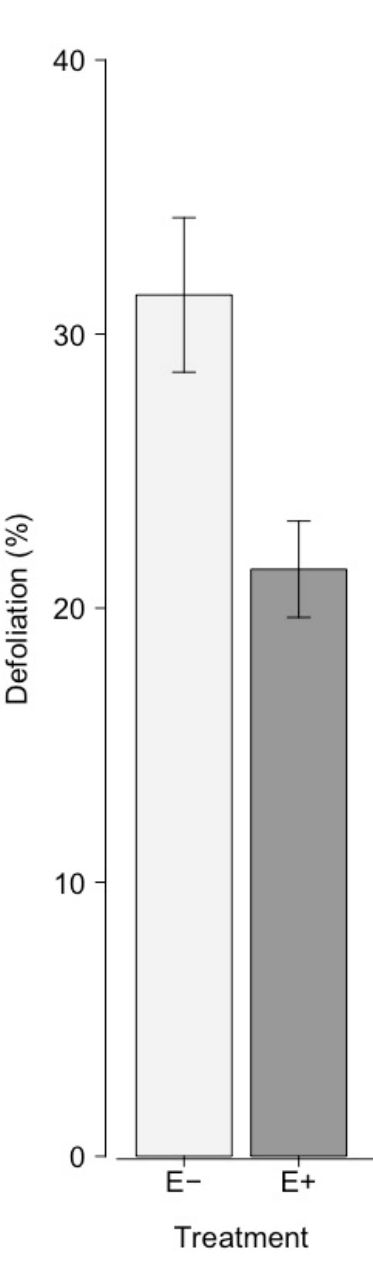
Figure 2. Mean (±SE) defoliation of white spruce trees by eastern spruce budworm. Thirty-two trees contained a native endophytic fungus (E+, dark bars) and 32 control trees did not (E−, light bars).